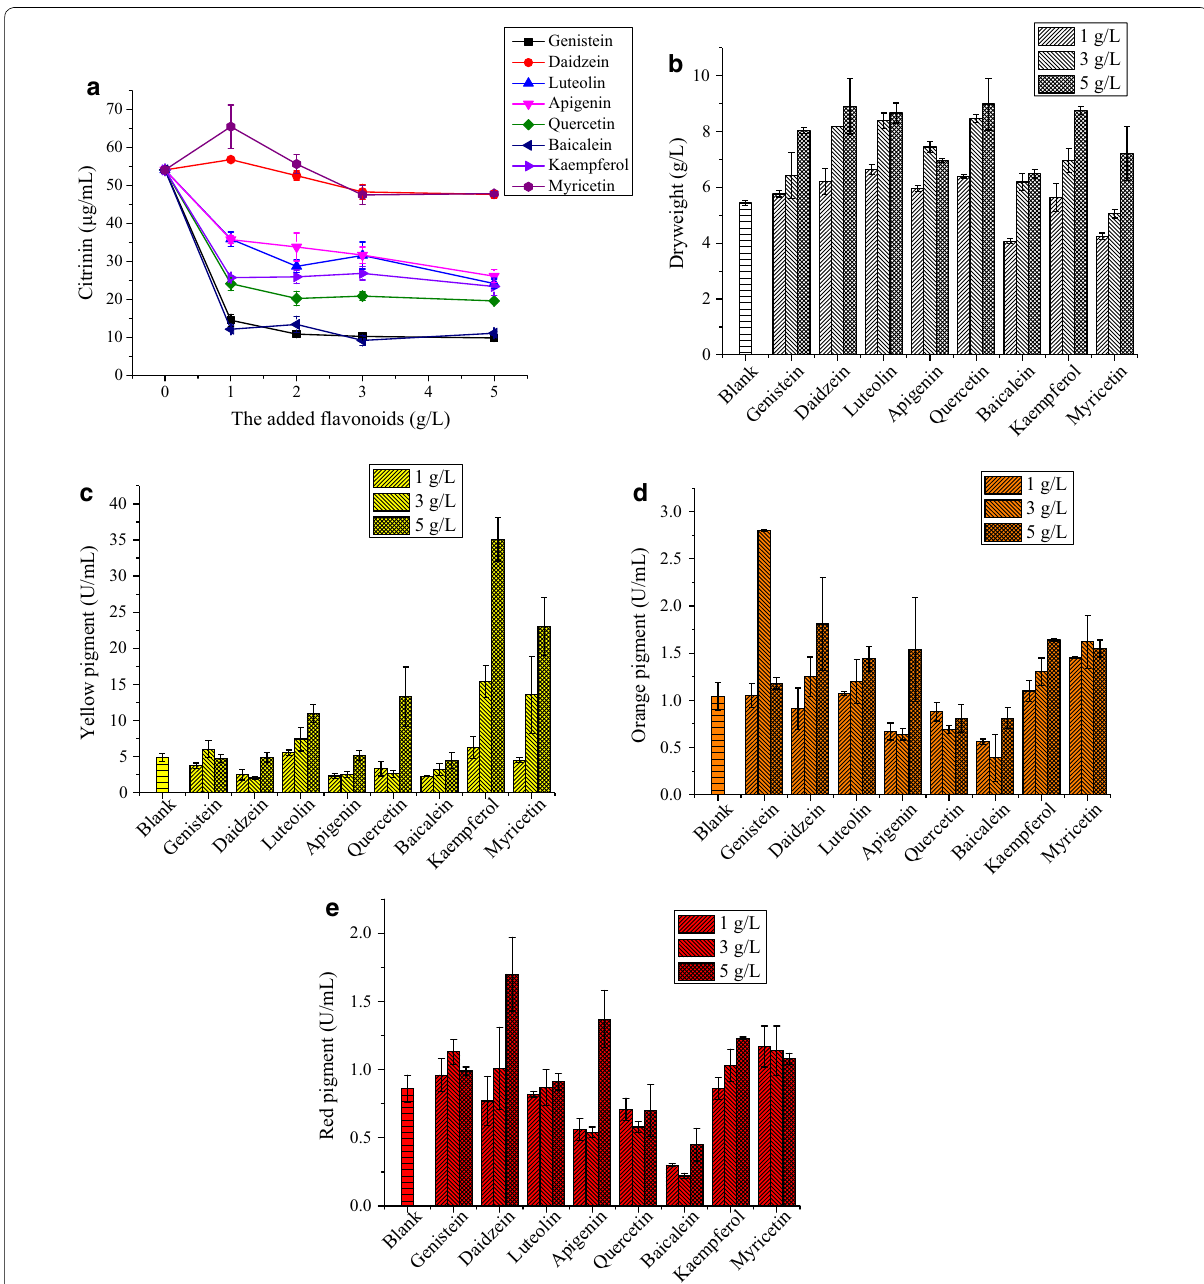
Fig. 4 Effects of different types and quantities of flavonoids (1.0–5.0 g/L) on a citrinin, b biomass, c yellow pigment, d orange pigment, and e red pigment production by MAL in liquid-state fermentation at 30 °C, 180 rpm for 12 days. Significant differences of different the columns at p <